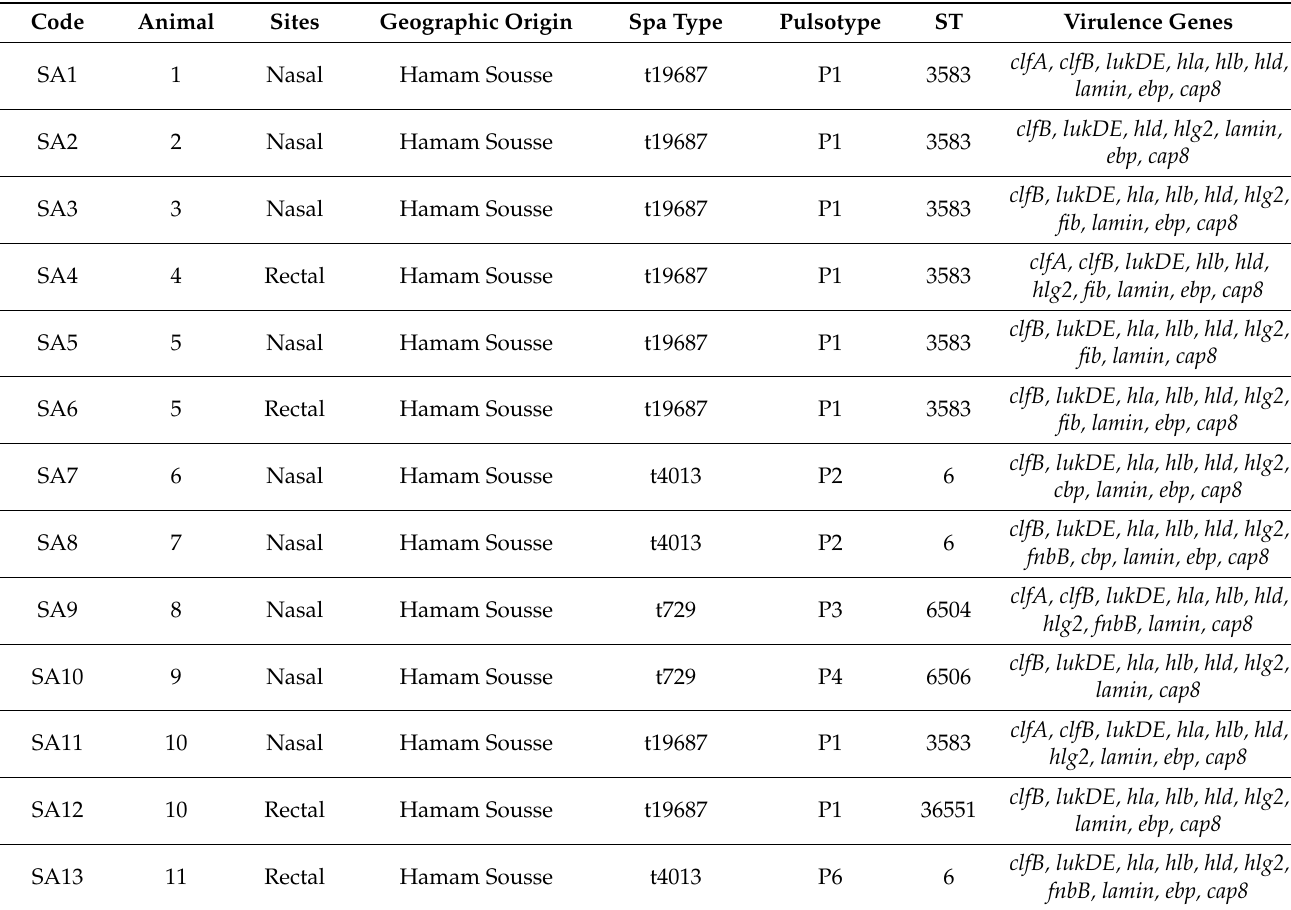
Figure 1. Dendrogram of pulsed-field gel electrophoresis Sma I patterns among 16 Staphylococcus aureus isolates recovered in this study, generated by GelCompar II software using the unweighted pair group method with arithmetic mean (UPGMA) algorithm and the Dice similarity coefficients. Table 2. Characteristics of the 16 S. aureus isolates recovered from 14 healthy camels.